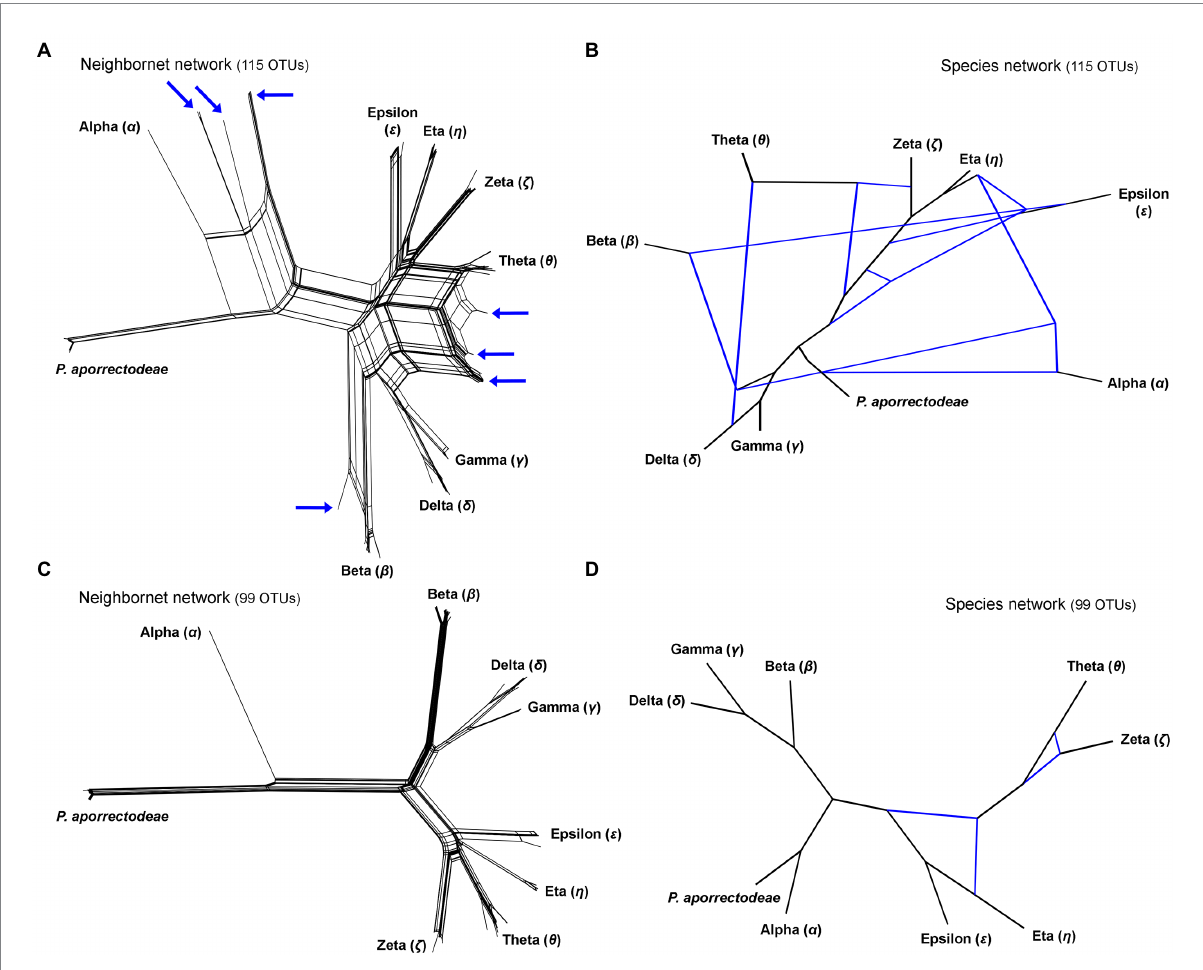
FIGURE 3 Split decomposition analyses (A,C) conducted in SplitsTree and species networks constructed in a pseudo-likelihood framework in PhyloNet (B,D) . (A,C) Neighbor-net networks constructed from the 115 and 99 specimens datasets. Specimens with conflicting positions in gene trees (see Figure 2) are marked by blue arrows. After their exclusion, the network becomes tree-like as shown in (C) . (B,D) Species networks constructed from the rDNA cistron and COI trees based on the 115 and 99 specimens datasets. Specimens with conflicting positions in gene trees were excluded from the 99 OTUs